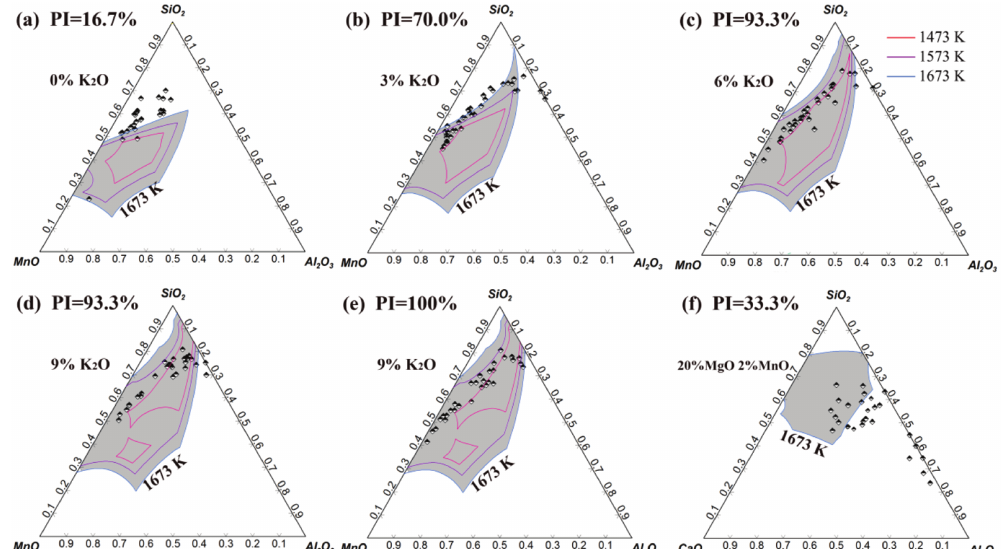
Figure 9: Composition distributions of inclusions in phase diagrams (PI – proportion of low melting point inclusions).